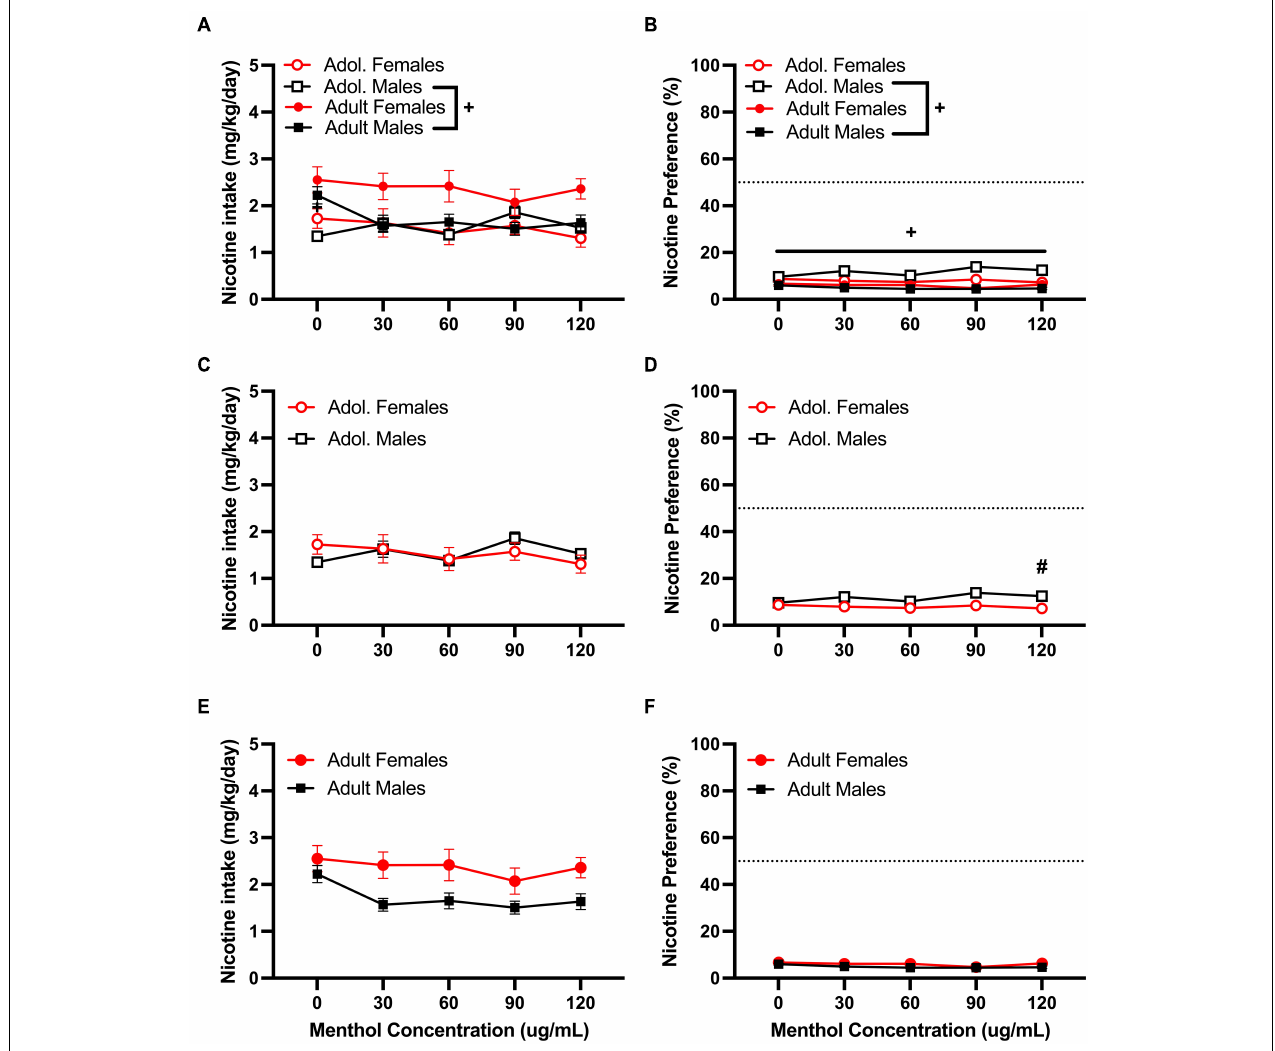
FIGURE 4 | Effects of menthol on oral nicotine (200 µ g/mL) aversion in adult and adolescent male and female DBA/2J mice. Mice were given a choice of DI water or menthol + nicotine [nicotine (200 µ g/mL) + menthol 0–120 µ g/mL] in a within-subject manner in the two-bottle choice paradigm. Intake is calculated as mg of drug per kilogram (mg/kg) of body weight and preference as the volume of drug solution consumed as a percentage of the total fluid consumed. (A,C,E) Average nicotine intake (mg/kg/day) and (B,D,F) nicotine preference (%) are shown. Data are presented as the mean ± SEM of 10–15 mice/sex/age. Results are based on a RM three-way ANOVA with age, sex, and menthol concentration as factors. + P < 0.05 vs. adults. * P < 0.05 vs. 0 µ g/mL. # P < 0.05 vs.